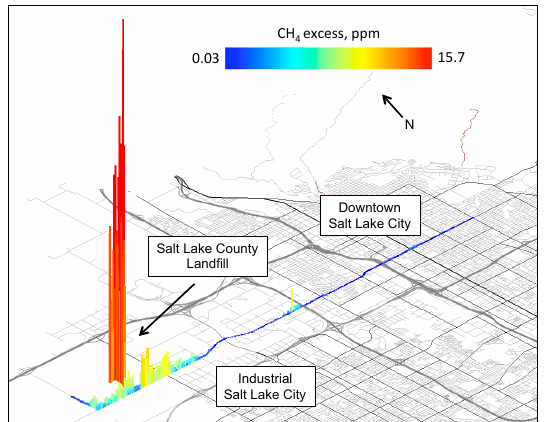
Figure 8. The CH 4 mole fraction across Salt Lake Valley, Utah, USA. Values shown represent mole fraction above background mole fraction obtained from Wendover, Utah. The underlying black and white grid shows roads, and the color bar shows the range of values